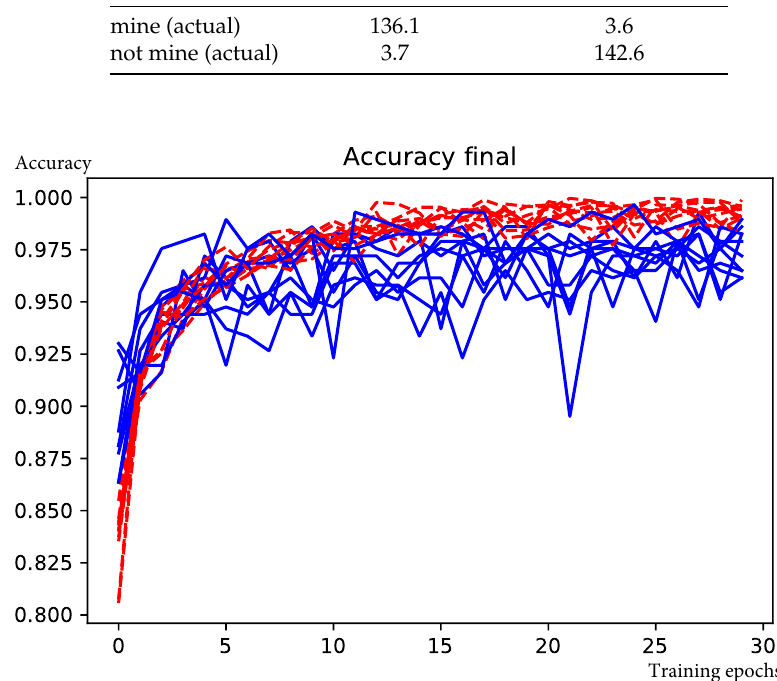
Figure 7. Evolution of accuracy for mines and dams detection over 30 training epochs and 10-fold cross validation. Red lines indicate training accuracy and blue lines validation